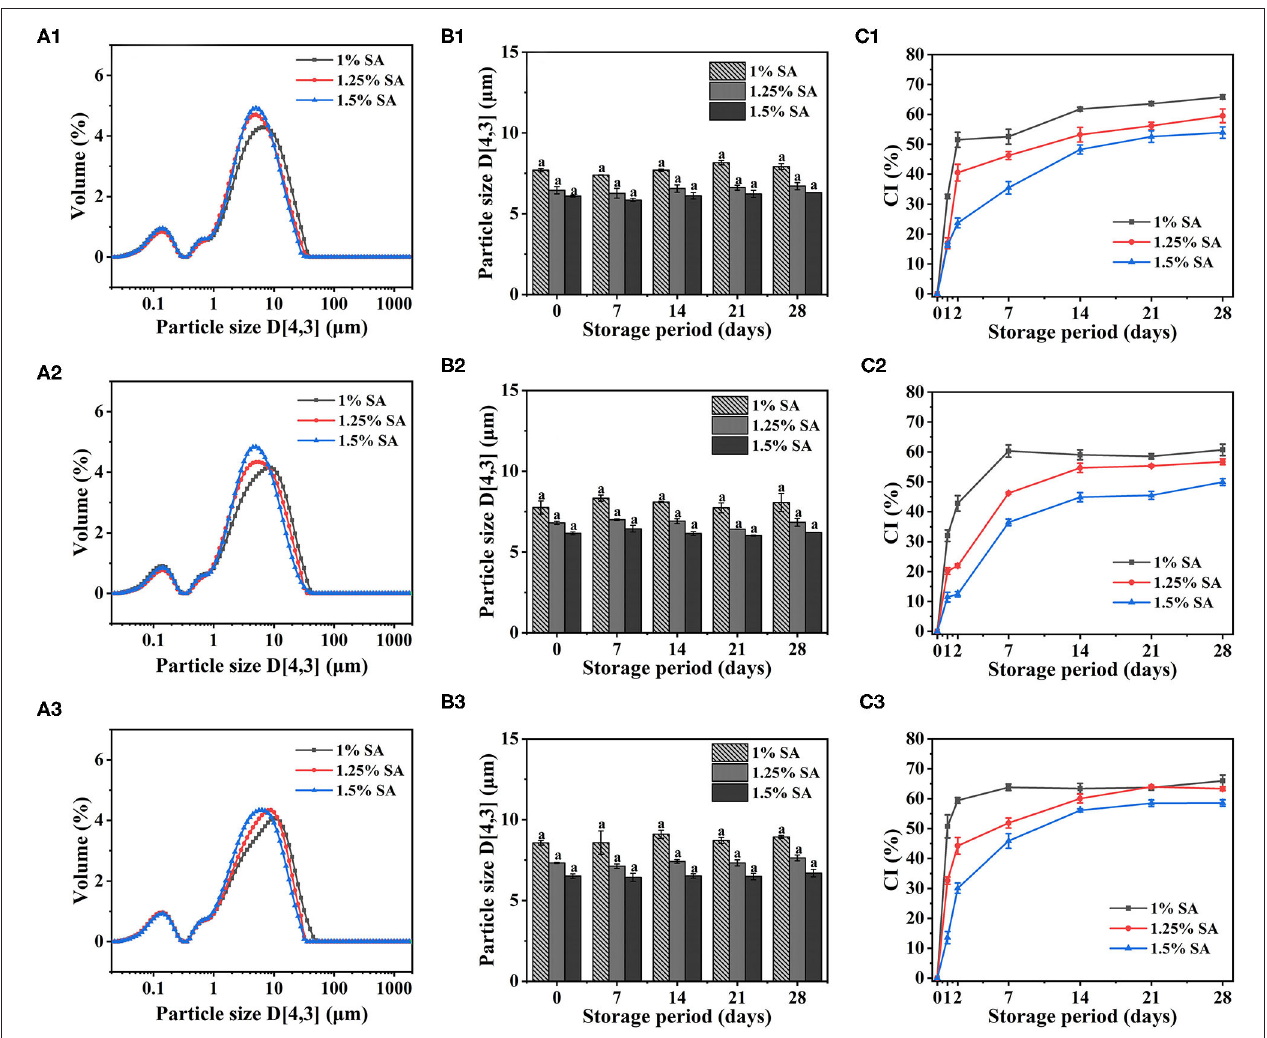
FIGURE 1 | Particle size distribution of E1 (A1) , E2 (A2) , and E3 (A3) emulsions. Particle size and creaming index of E1 (B1,C1) , E2 (B2,C2), and E3 (B3,C3) emulsions at different storage times. The error bars represent standard errors of the means.